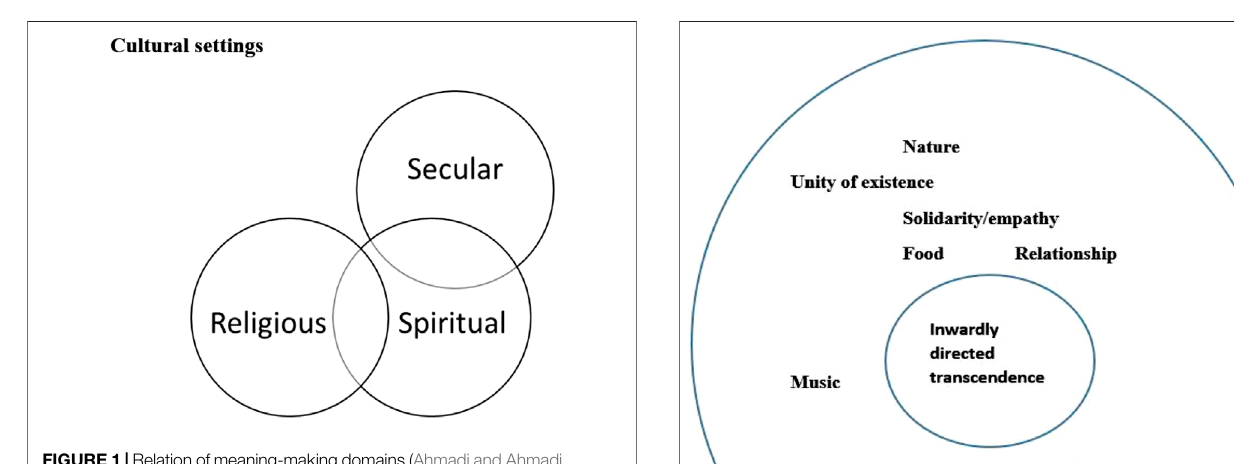
FIGURE 1 | Relation of meaning-making domains (Ahmadi and Ahmadi, 2018, p.136, p.136).